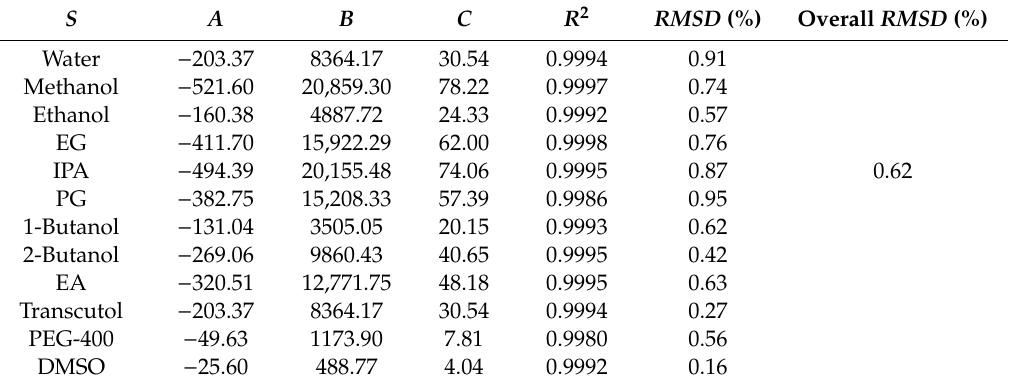
Table 3. The Apelblat parameters ( A, B and C ), R 2 and RMSD (%) for PPD in di ff erent neat solvents ( S ).